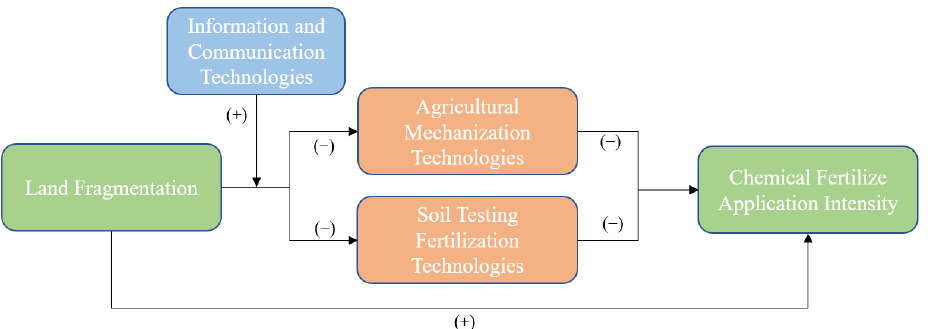
Figure 3. Influence mechanism of technology adoption on land fragmentation and CFAI.